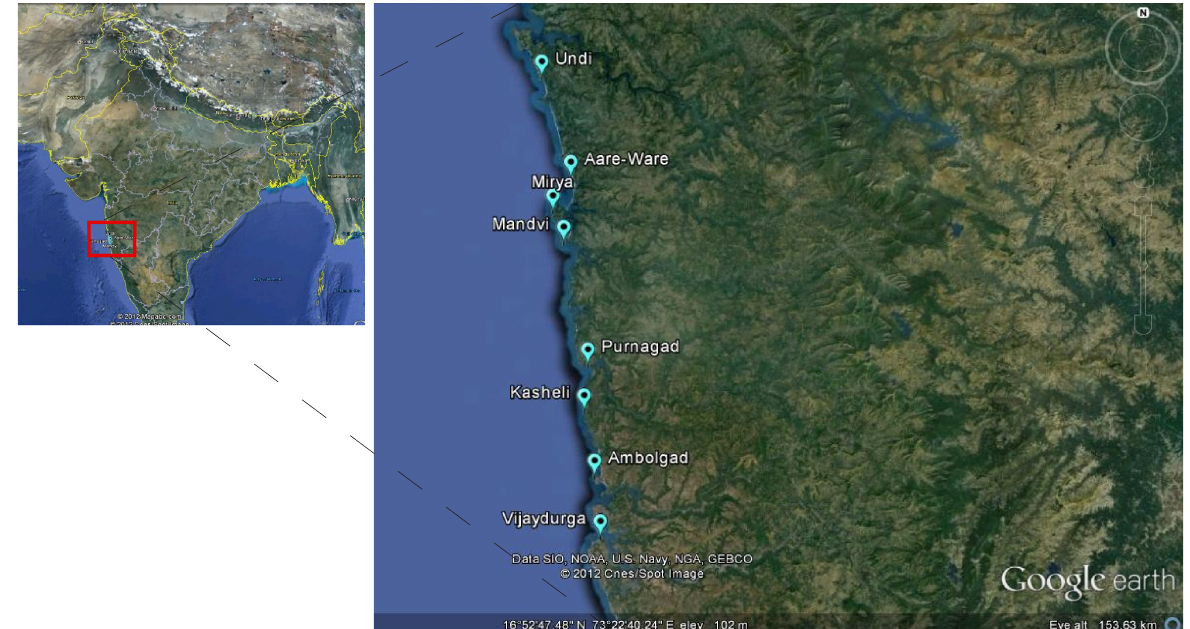
Image 1. Collection sites along Konkan coast, Maharashtra. (Courtesy: Google Earth)